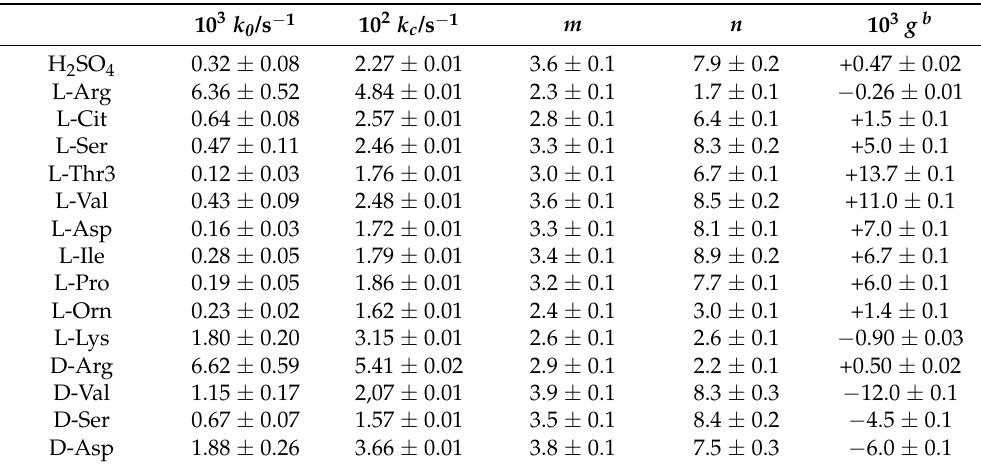
Table 1. Kinetic parameters ( k 0 , k c , m and n ) together with the dissymmetry factor g for the J-aggregation of TPPS 4 induced by H 2 SO 4 in the presence of various amino acids a .